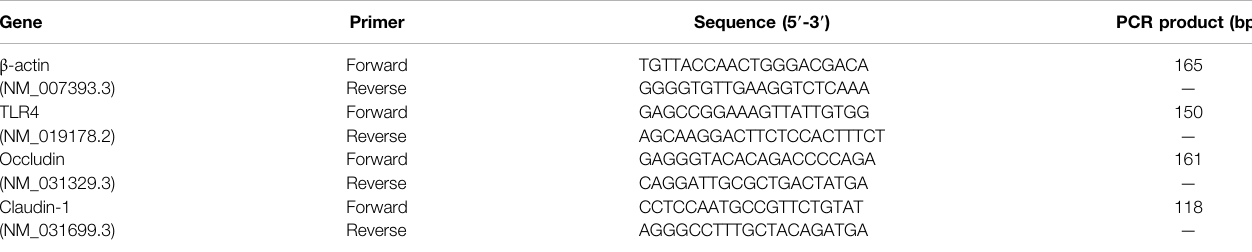
TABLE 1 | Real-time RT-PCR oligonucleotide